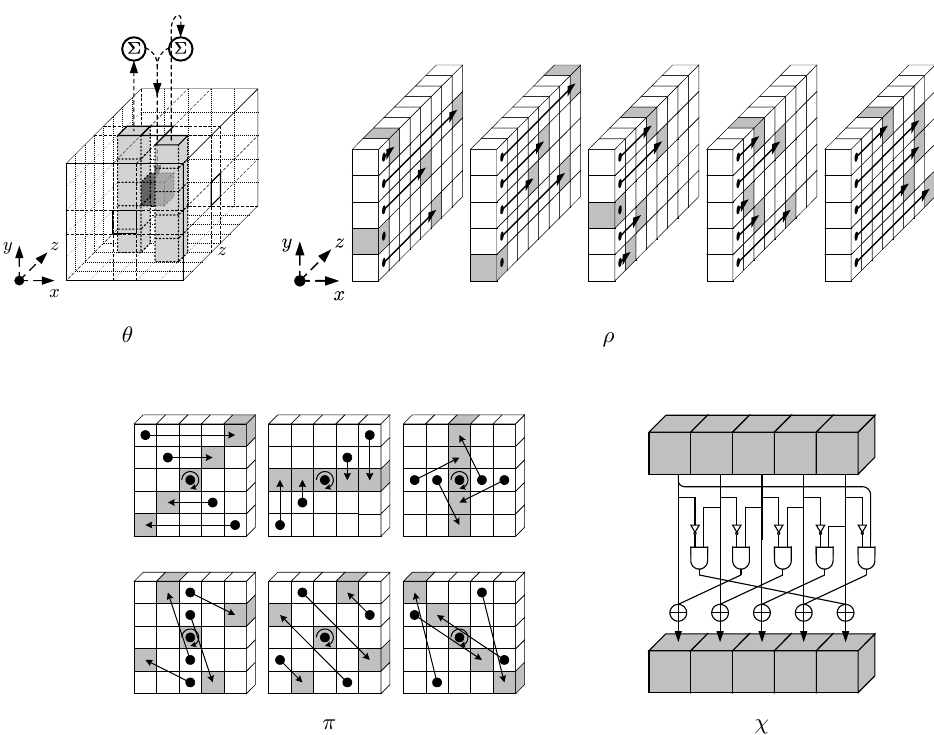
Figure 6: The Keccak permutation steps (taken from